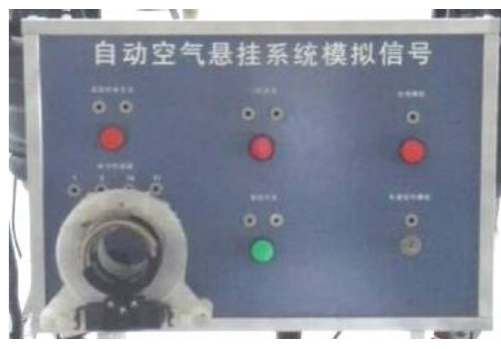
Fig. 4 Suspension System Speed Led.